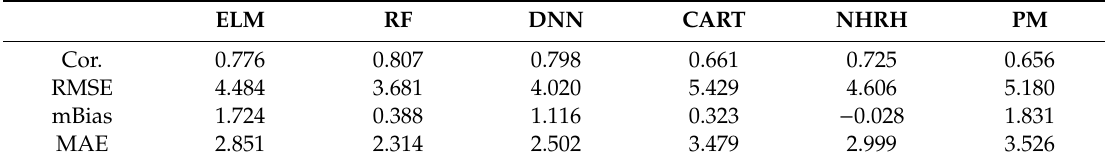
Figure 5. Quantile-Quantile plots of six LWD prediction models. Noted that null speed is replaced by 0.1 m / s for LWD prediction from the PM model, and the correct predictions for a zero value of LWD are excluded for all models. Table 3. Evaluation results for all data.